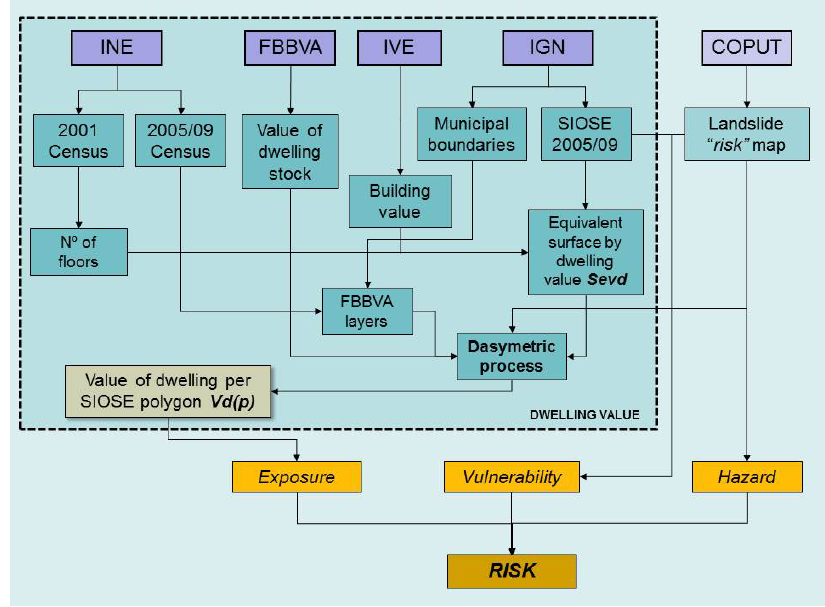
Figure 2. Flow diagram. INE: Spanish National Statistics Institute; FBBVA: Foundation of the BBVA bank; IVE: Building Institute of Valencia (Valencia Government); IGN: Spanish National Geographical Institute; COPUT: Department of Public Works, Town Planning and Transport: Valencia Government.